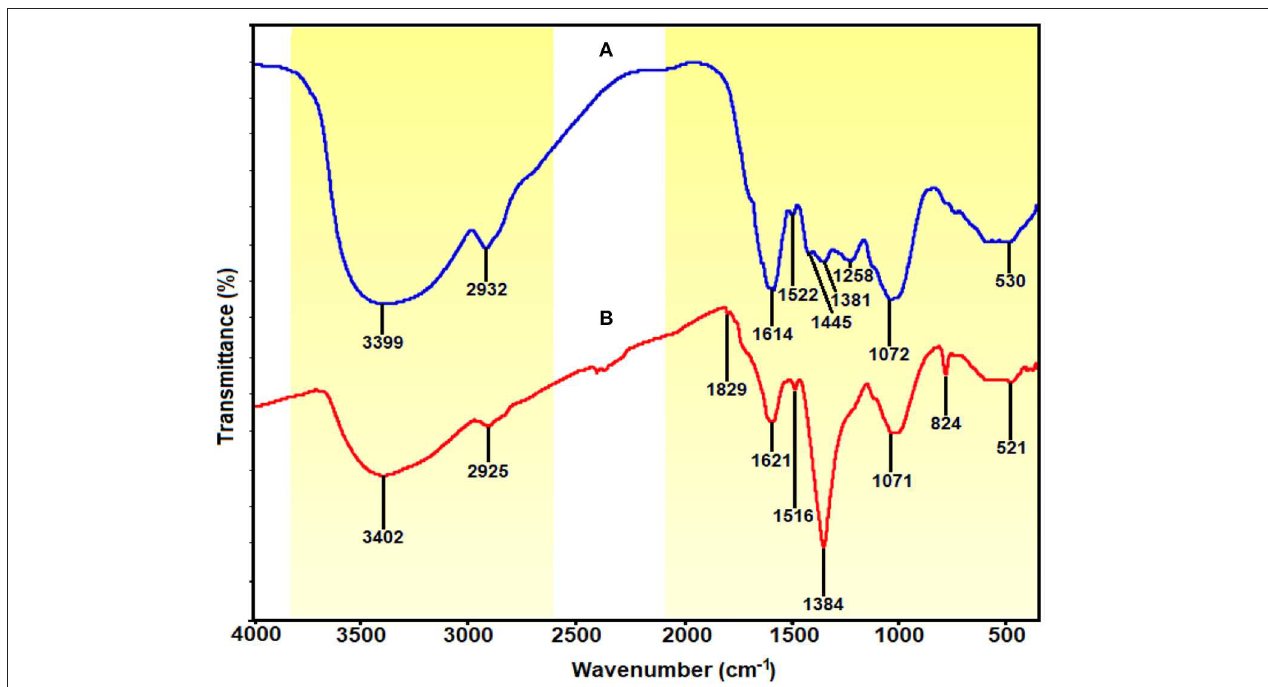
FIGURE 8 | FTIR spectra of (A) E. spiralis extract at 2.5g of E. spiralis dosage and (B) E. spiralis /Ag-NPs at best parameters of the biosynthesis process.